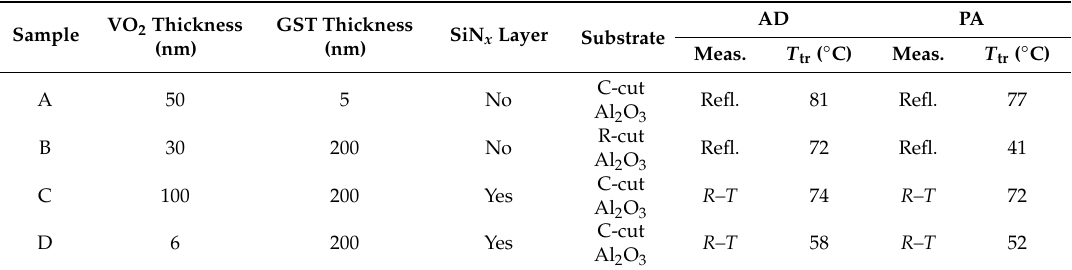
Figure 2. XRD 2 θ − ω scan profiles of Sample B in geometries aligned with respect to VO 2 40–2 M or 002 R di ff raction peak. The profiles are o ff set for clarity. Inset shows a schematic of unit cells of R phase VO 2 and the incident and reflected x-ray. Table 1. Thickness of each layer, measurements performed at each step, and the results of T tr in heating runs from each measurement in four